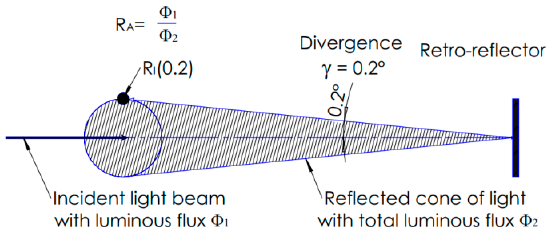
Figure 1. Illustration of characteristic retroreflection of reflex reflector.